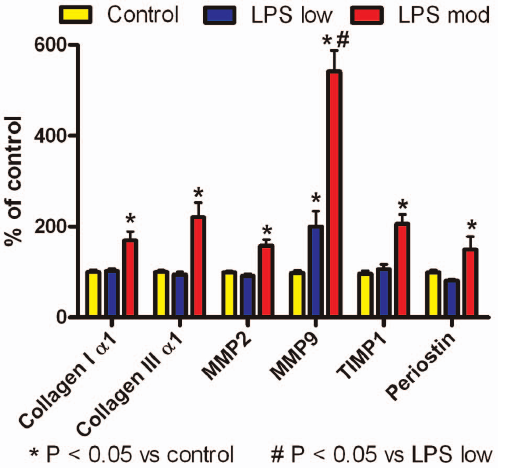
Figure 8. LPS dose-dependently increased expression of fibrosis-related genes in the left ventricle. Expression of fibrosis- related genes in the left ventricle measured by QRT-PCR (mean + SEM) after 12–15 weeks of weekly i.p. injections of moderate dose LPS (12 6 1 mg/kg, n=15), low dose LPS (0.5 6 0.1 mg/kg, n=12) or saline (control, n=17). Collagen 1 a 1, collagen III a 1, MMP2, MMP9, TIMP1, and periostin increased with moderate dose LPS compared with low dose LPS or saline (P , 0.05). Low dose LPS increased MMP9 compared with saline (P , 0.05).